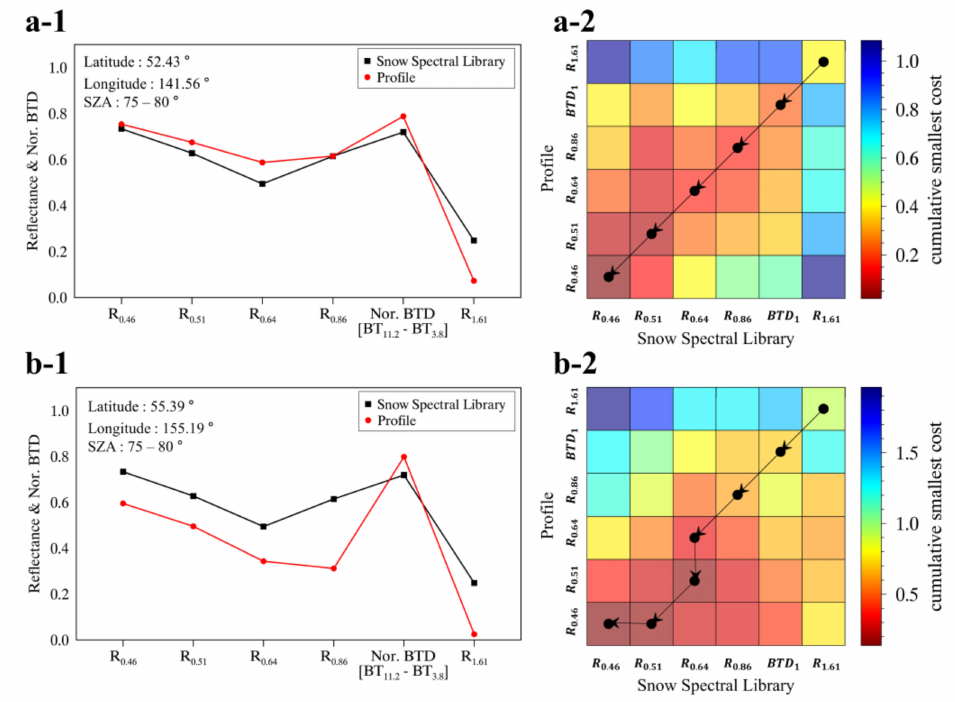
Figure 7. DWW method applied to GK-2A / AMI sea-ice detection algorithm, ( a-1 , b-1 ); snow spectral library ( X -axis: R 0.46 , R 0.51 , R 0.64 , R 0.86 , Nor. BTD 1 , R 1.61, Y -axis: reflectance and Nor. BTD 1